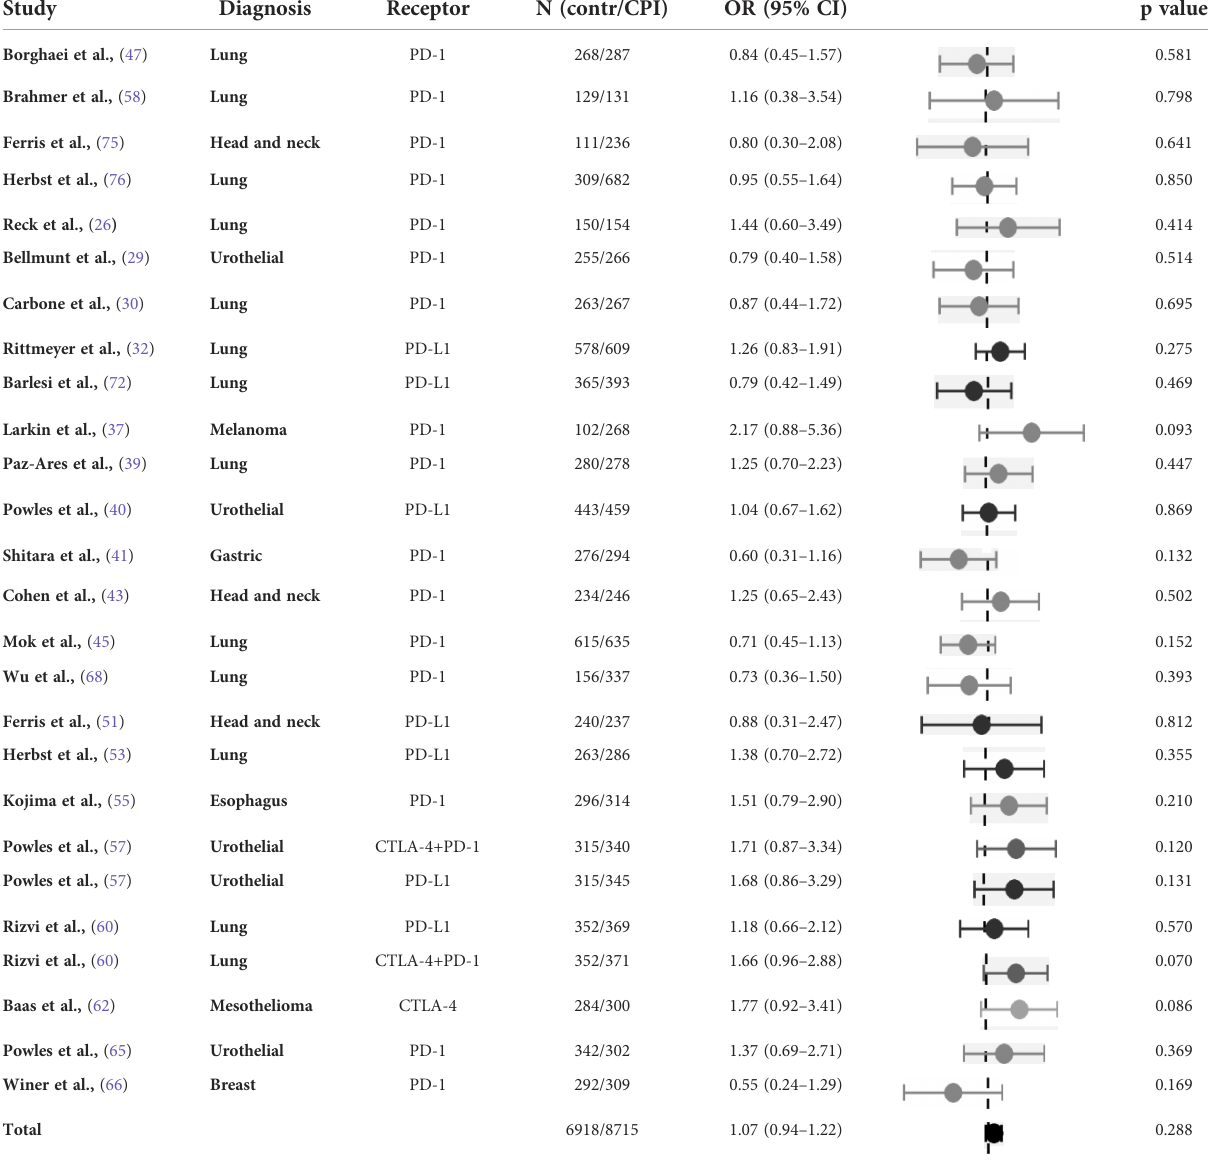
TABLE 6 Odds ratio of insomnia in randomised studies of checkpoint inhibitors versus chemotherapy (control arm as reference).